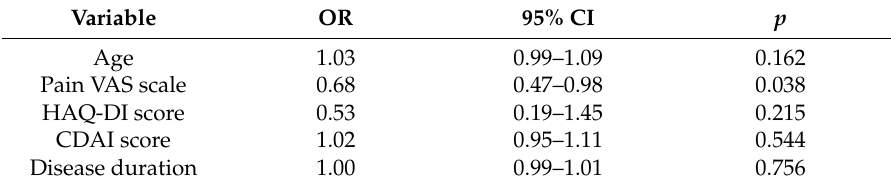
Table 4. Logistic regression model of variables associated with optimal sleep